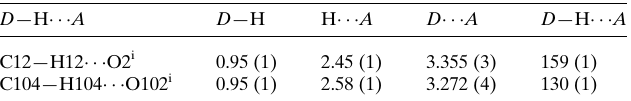
Table 1 Hydrogen-bond geometry (A˚ , (cid:3) ).